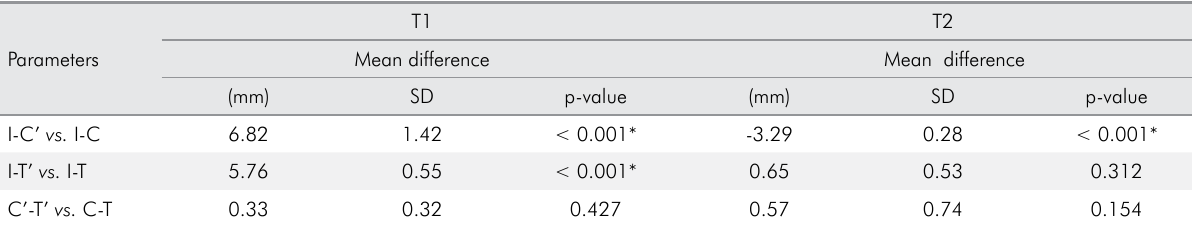
Table 2. Analysis of palate symmetry in the evaluated period (paired t test).